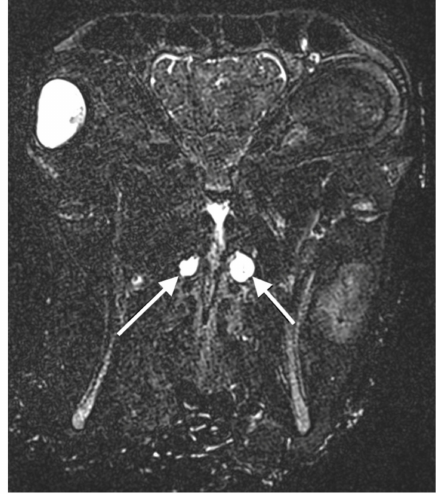
Figure 4. MRI images of a cadaver head (cases 22 and 23). The HA depots are marked by white